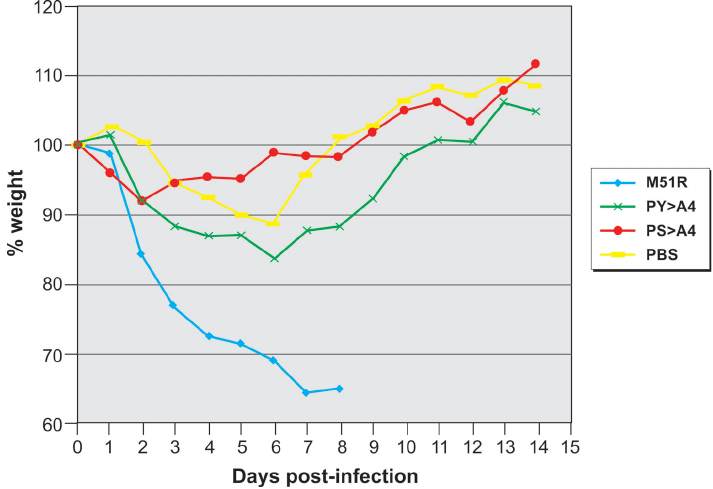
Figure 2. Graph of weight change in virus infected mice. Graphic depiction of the average % weight loss/gain for mock-infected mice (PBS, yellow), or mice infected with M51R (blue), PY > A4 (green), or PS > A4 (red). Weights were determined post-infection on a daily basis for a two-week period.